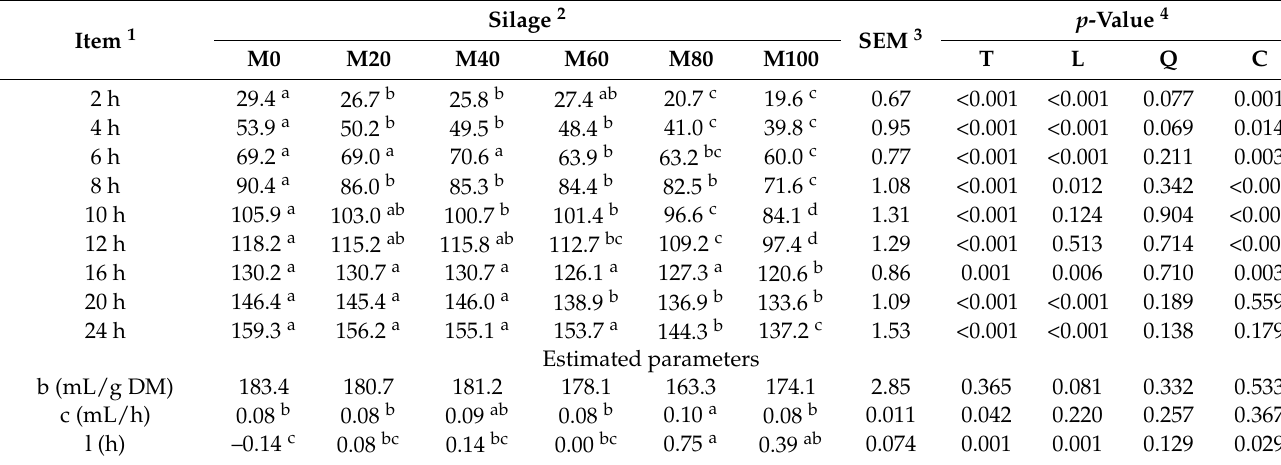
Table 5. In vitro gas production (mL/g DM) dynamics and estimated parameters of silage prepared with lucerne, sweet maize stalk, and their mixtures ( n =